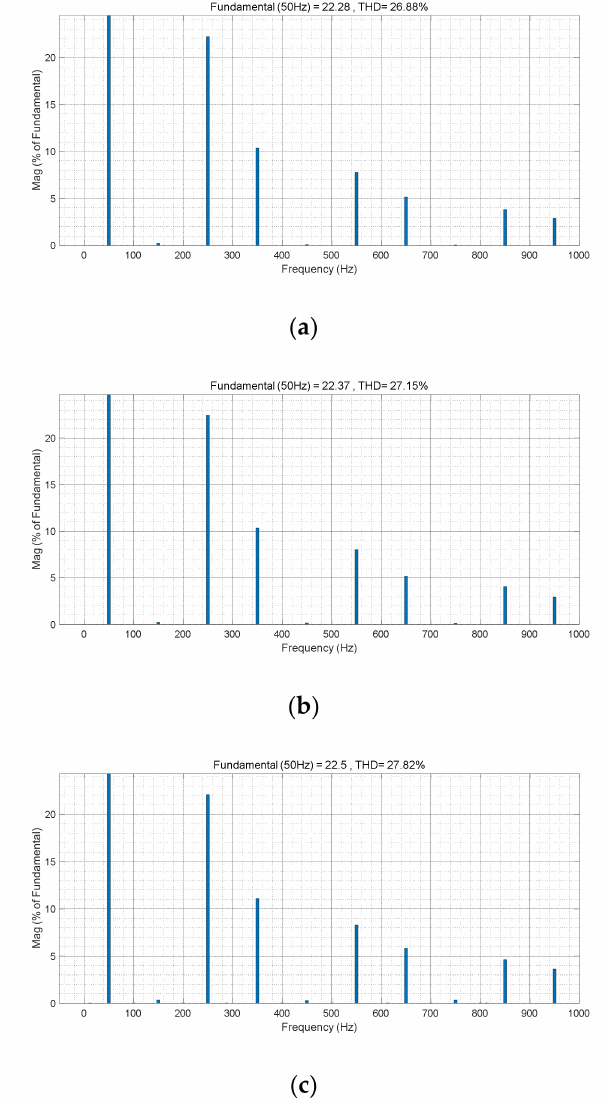
Figure 15. Current distortion rate of the transformer’s load-side winding under different operating scenarios. ( a ) The distortion rate of the transformer’s load-side winding current without any filtering device. ( b ) The distortion rate of transformer’s load-side winding current considering the 5th and 7th fully tuned branches. ( c ) The distortion rate of transformer’s load-side winding current under the proposed HIAF